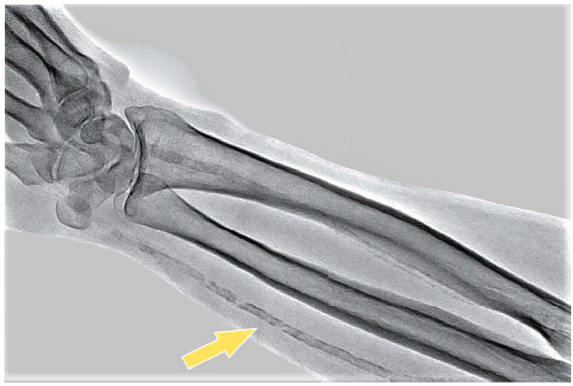
Figure 4: Forearm radiography: diffuse mediocalcinosis along the entire length of the radial artery (arrow).